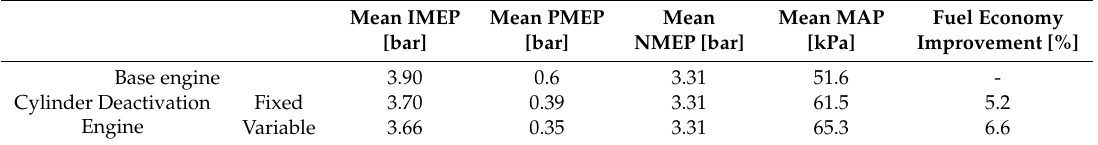
Table 4. Summary of mean engine performance data under cylinder deactivation in